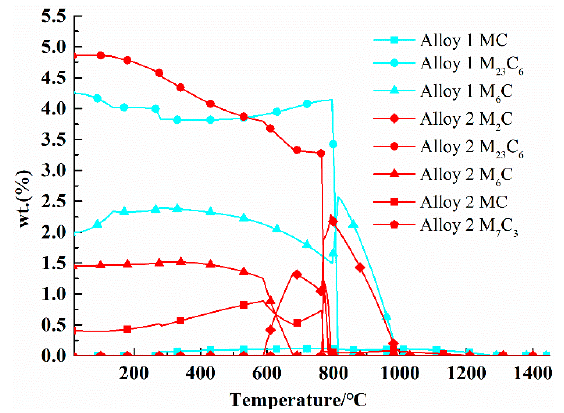
Figure 7. Comparison of carbides—both materials. Table 6. Comparing the information calculated from the balance phase of alloy 1 and alloy 2.